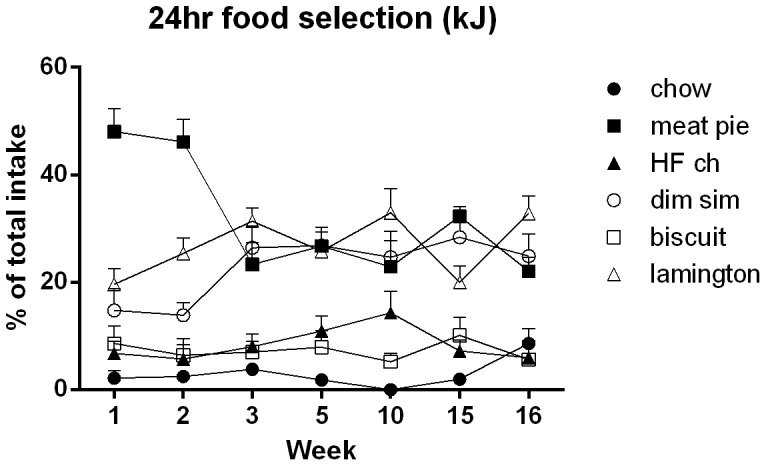
Food selection during 24 hr energy intake measures in cafeteria-fed rats.Proportion of each food type selected as a percentage of total intake (kJ), in cafeteria diet fed rats (chow, closed circles; meat pie, closed squares; high fat chow, closed triangles; dim sim, open circles; biscuit, open squares; lamington, open triangles). Data are shown as mean (±SEM) and were analyzed via repeated measures ANOVA (n = 6 cages per group).